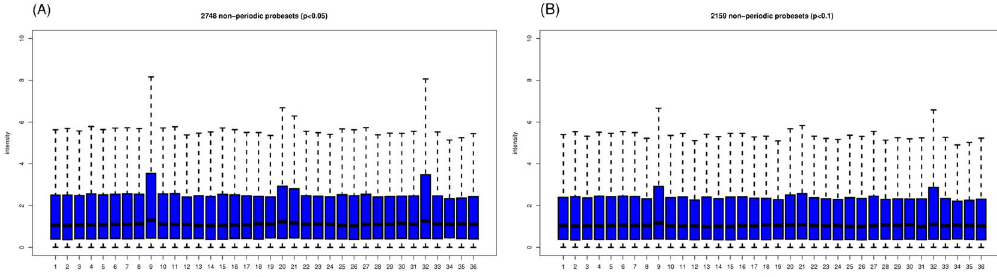
Figure 2. Boxplots of the expression profiles of non-periodic probesets with two cut-off criteria: (A) p , 0.05 and (B) p , 0.1.